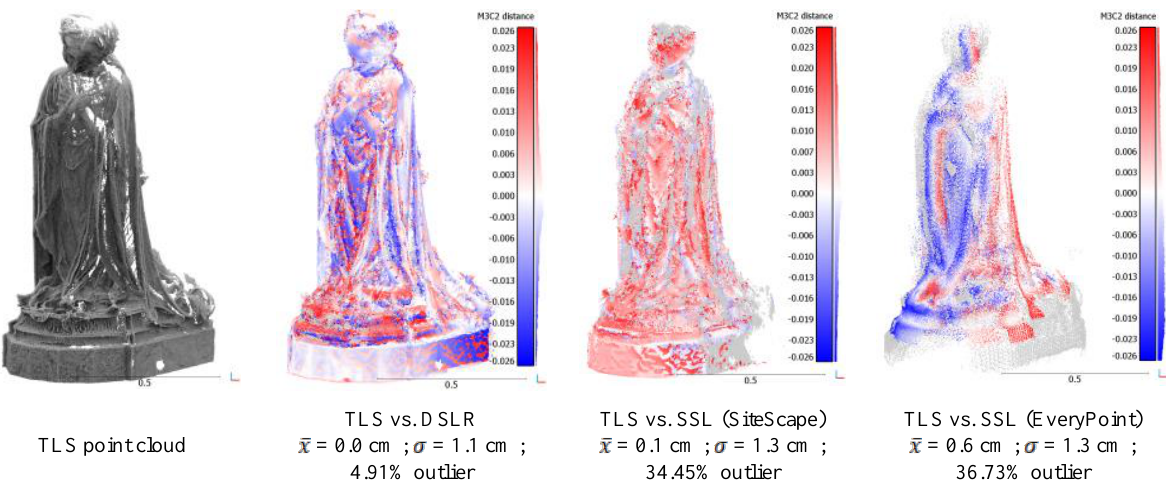
Figure 2. Results and comparison of the tested techniques for case (1). For this figure, the M3C2 analysis was performed using the TLS point cloud as reference data. denotes average deviation in 3D Euclidean distance, denotes standard deviation. Greyed points are outliers with deviations bigger than the set